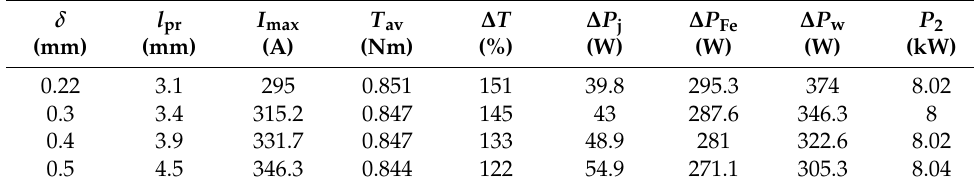
Table 5. Results of the air-gap-size